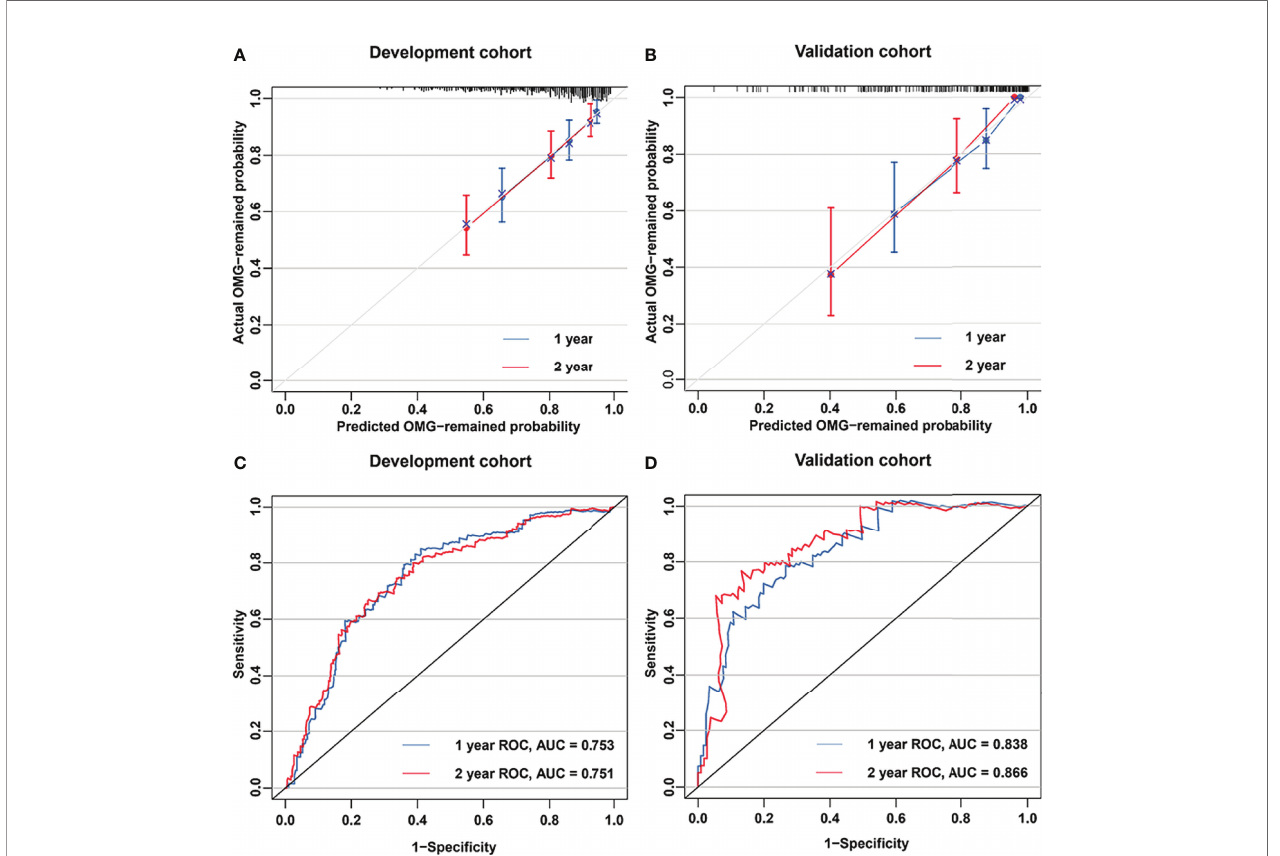
FIGURE 3 | Nomogram performance. Calibration plots for estimating 1- and 2-year generalization probabilities are presented for the development cohort (A) and validation cohort (B) . The x- and y-axes represent the nomogram-predicted and actual generalization probabilities, respectively. The 45° grey line is the reference line indicating a perfect calibration. The blue and red lines represent the nomogram-predicted 1- and 2-year generalization probabilities, respectively. Areas under the curves of the model for predicting 1- and 2-year generalization probabilities in the development cohort (C) and validation cohort (D) . The red and blue lines represent the nomogram-predicted 1- and 2-year generalization probabilities, respectively. TABLE 3 | Comparison of clinical characteristics between the low- and high-risk groups in the development and validation cohorts. Development cohort (n=351) P -Value Validation cohort (n=150) P -Value Low-risk High-risk Low-risk (n=224) (n=127)